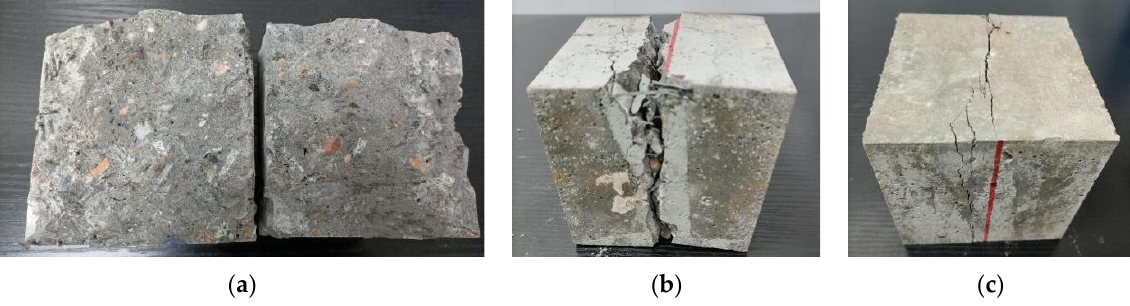
Figure 11. Failure modes in splitting tensile tests: ( a ) v sf = 0%; ( b ) v sf = 1%; ( c ) v sf = 2%.